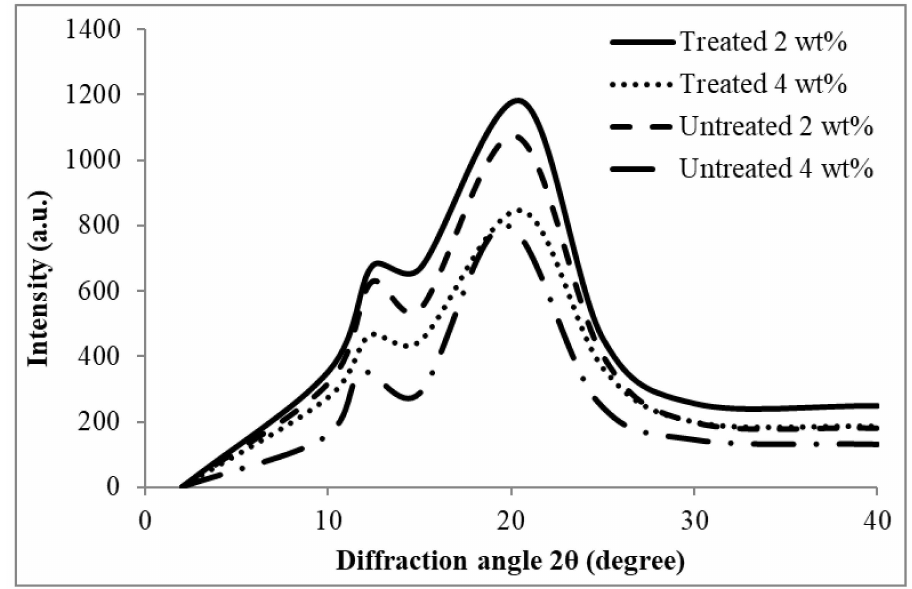
Figure 5. XRD pattern of untreated and MMA-treated RC biocomposite films containing 2 and 4 wt%